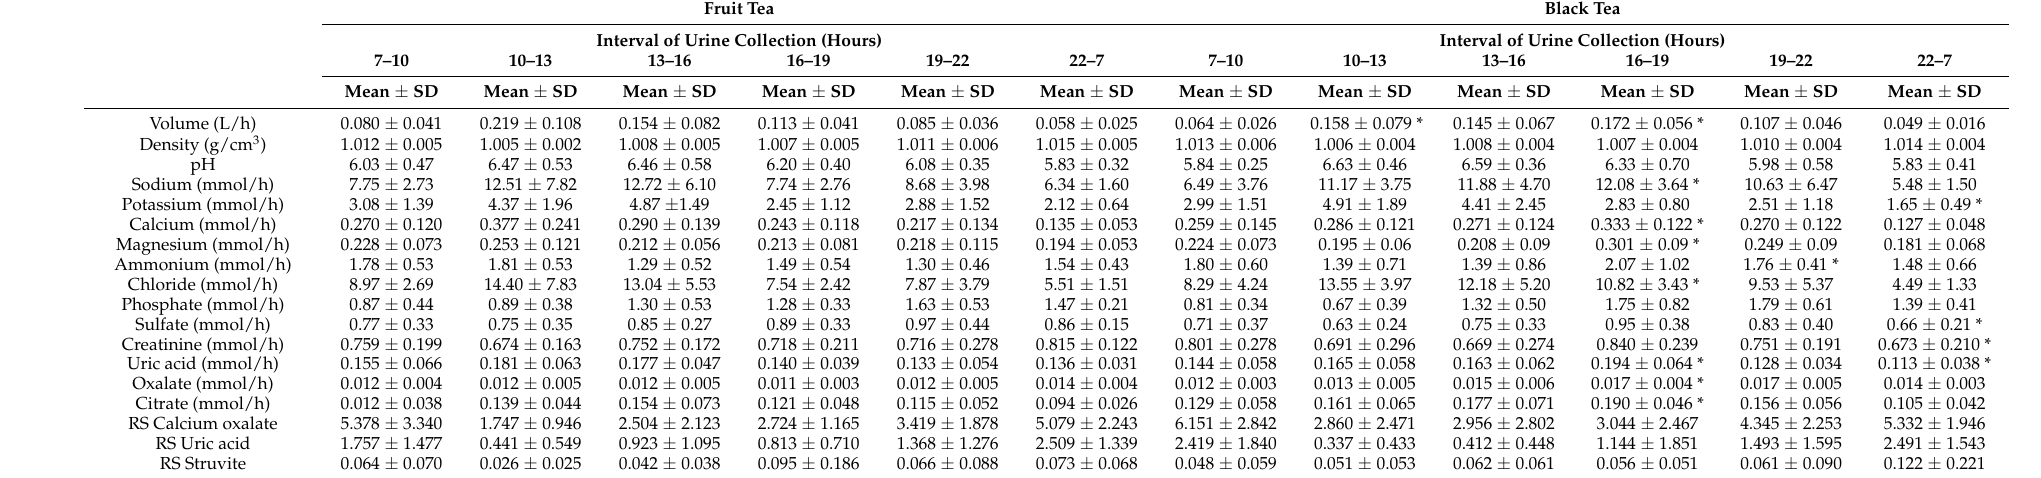
Table 2. Fractional urine composition after the consumption of fruit tea (control day) and black tea (test day) ( n =